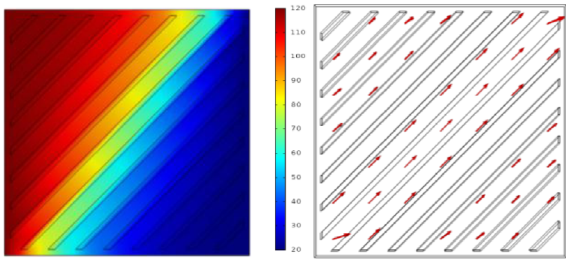
Fig. 1. Thermal signature ( ° C) in the simulated unit cell to direct heat at a 45 ° tilt (left), heat fl ux in the unit cell (right).